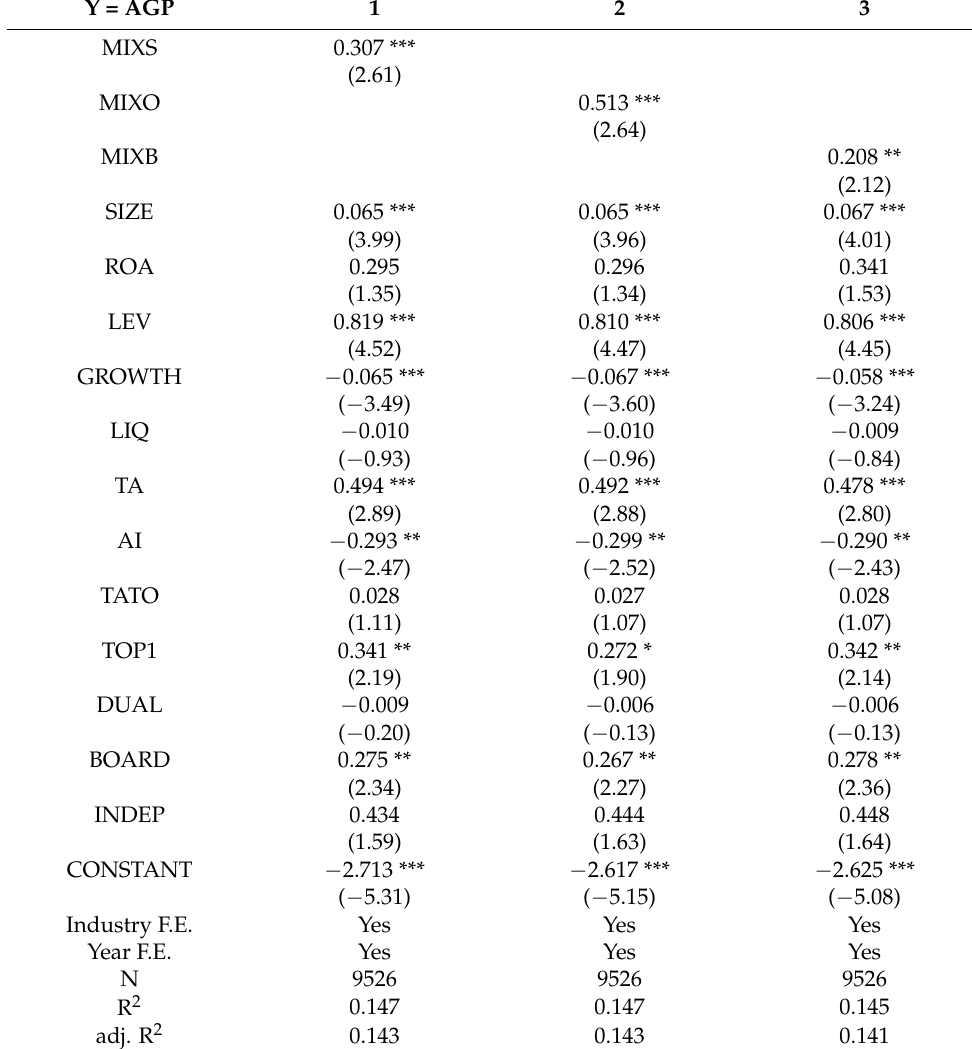
Table 3. The impact of mixed-ownership reform on the green transformation of SOEs. Y =